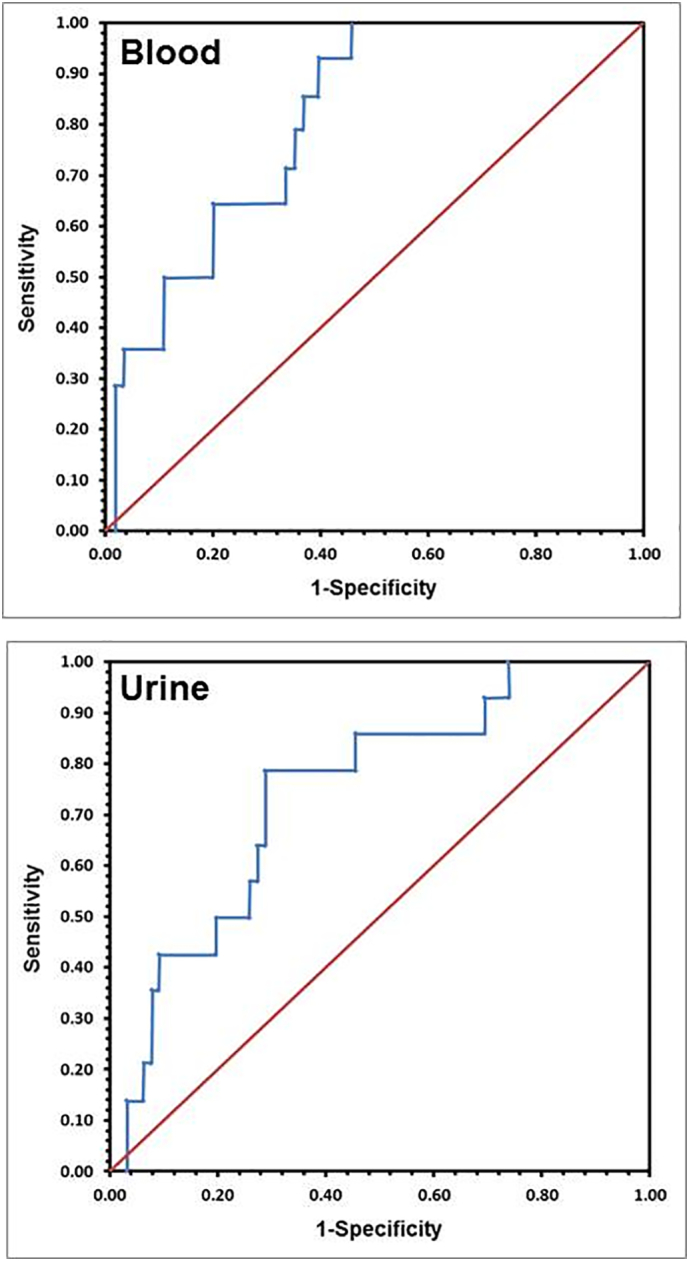
ROC curves for Ca isotope values in blood and urine for the prediction of osteoporosis. The best cut off in blood for δ44/42CaBlood values was found at about −0.85‰ which predicts osteoporosis (without vitamin d deficiency) for values lower or equal with a sensitivity of 100% and a specificity of 54.5%.The best cut off value for Ca isotopes in urine for δ44/42CaUrine was found at about 0.16‰ which predicts osteoporosis (without vitamin d deficiency) for values lower or equal to a sensitivity of 78.6% and specificity of 71.2%.